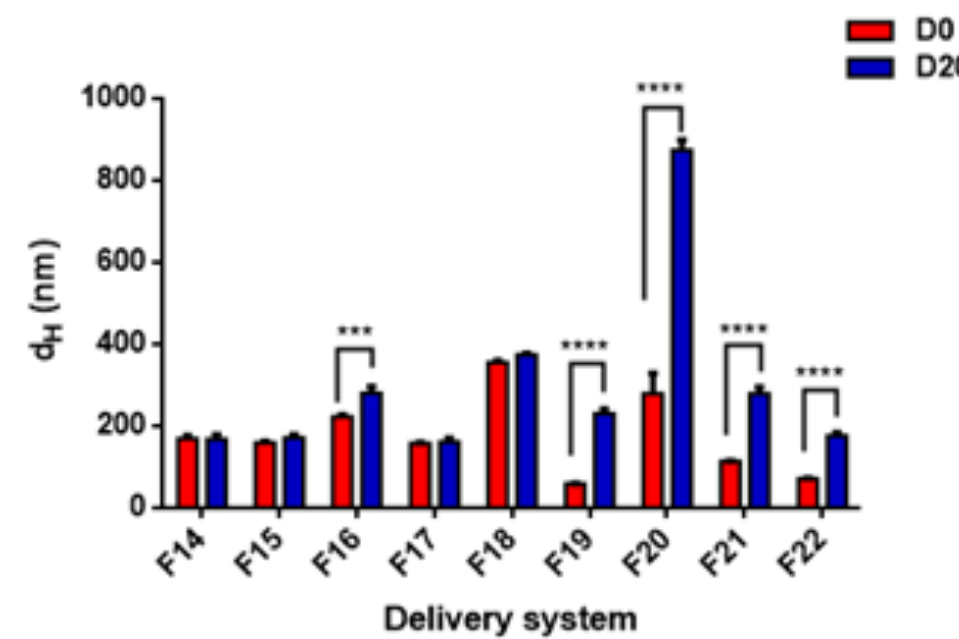
Figure 9. Effect of storage time on the stability of TC2 EO nanoemulsions (formulations F14–F18) and nanoparticles (formulations F19–F22). Statistical significance: *** p < 0.001 (very significant); **** p < 0.0001 (highly significant). Legend: day 0 (D0), day 60 (D60).